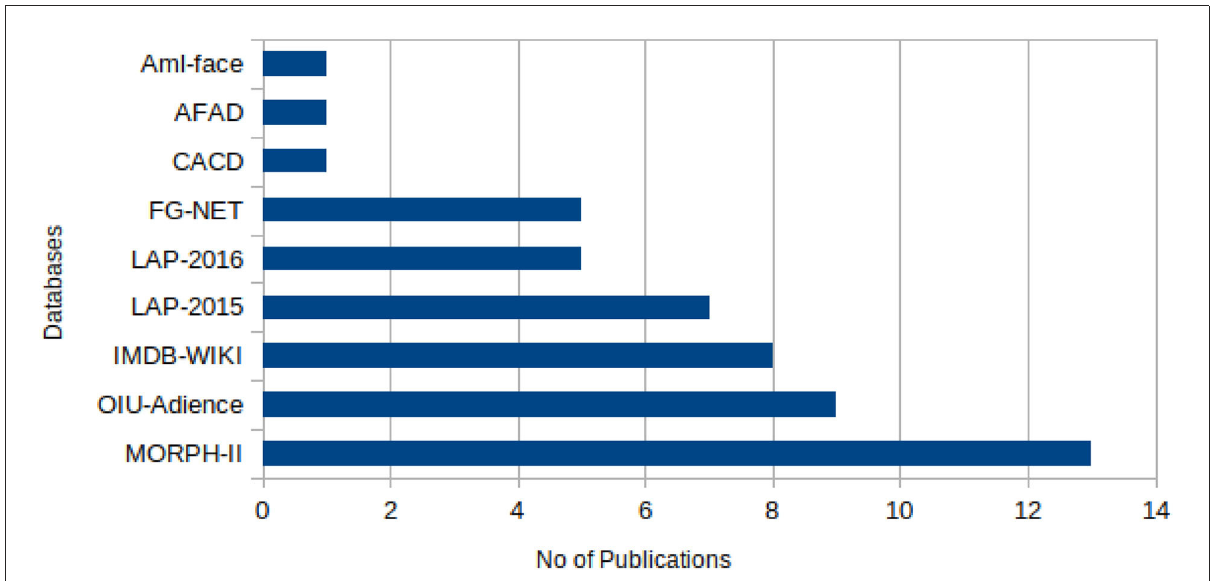
algorithms employed by researchers, highlighting their strengths future